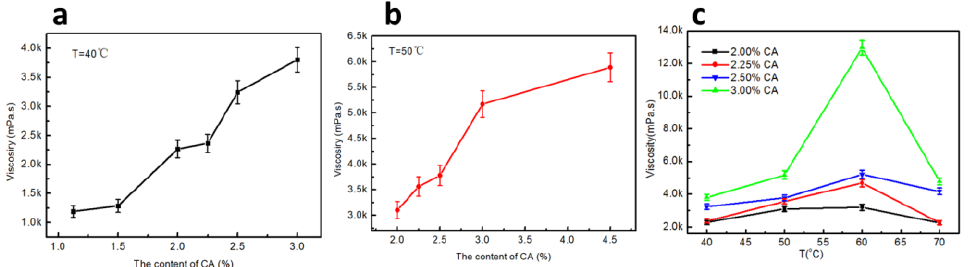
Figure 1. ( a ) Effect of CA content on viscosity of ternary blend adhesive at 40 °C; ( b ) Effect of CA content on viscosity of ternary blend adhesive at 50 °C; ( c ) Effect of CA content on viscosity of ternary blend adhesive at different temperatures.